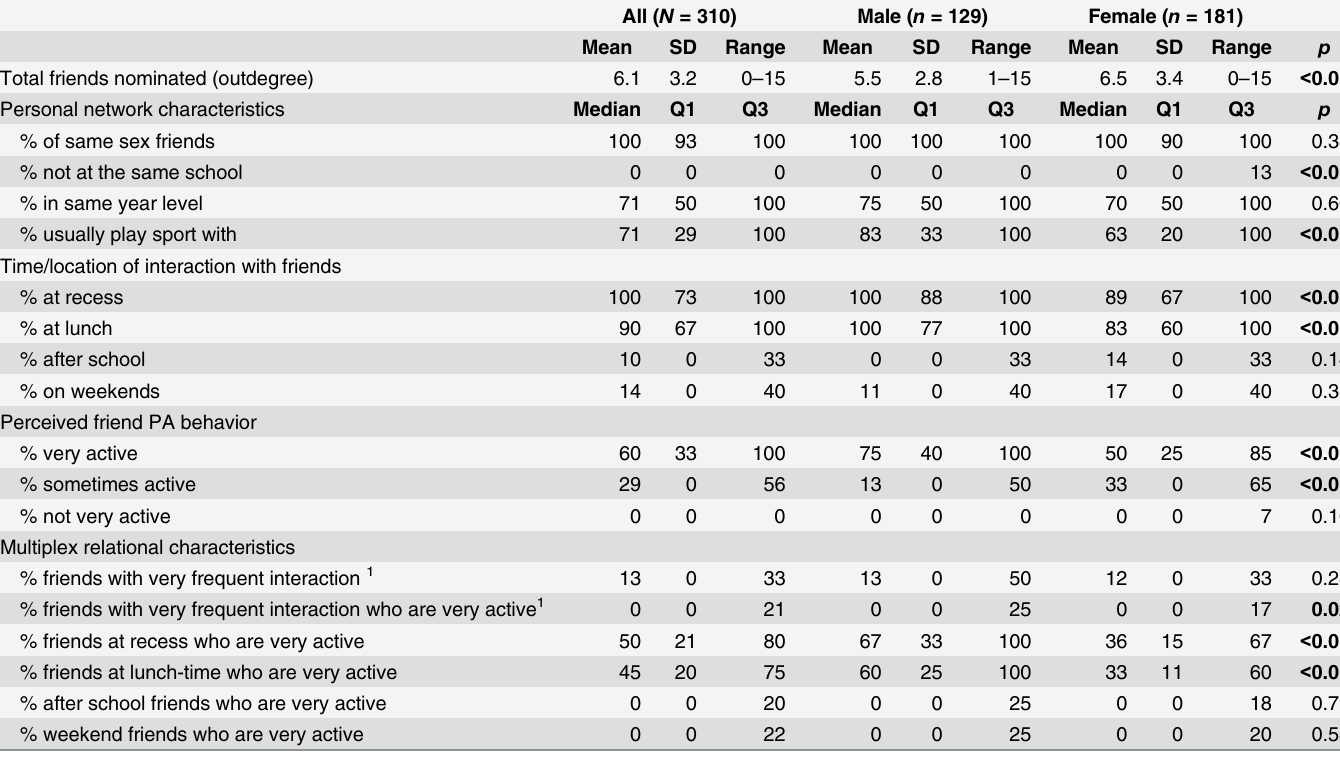
Table 2. Participant characteristics: personal friendship